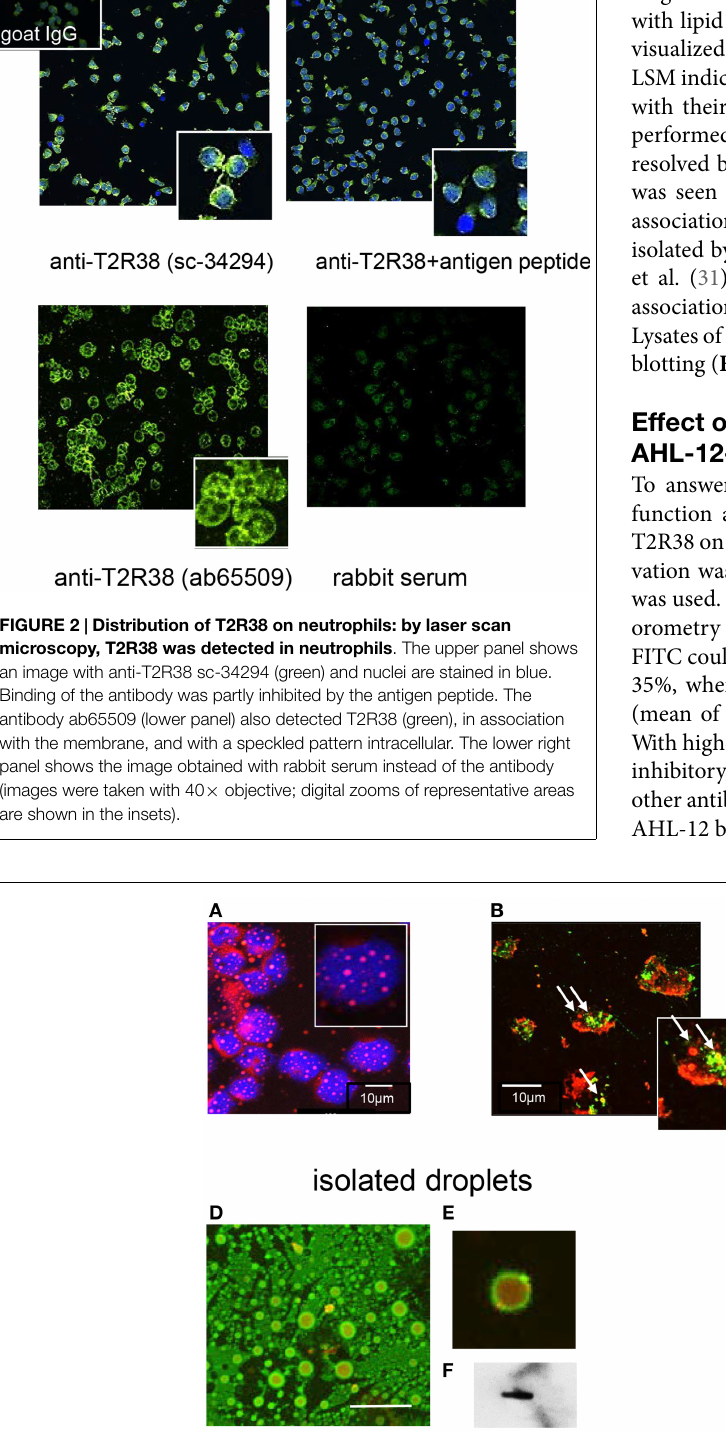
FIGURE 3 | Association of T2R38 with lipid droplets: (A) shows neutrophils stained with Nile red to visualize the lipid droplets; nuclei are in blue . (B) With anti-T2R38 (green) and staining with Nile red, droplets containing T2R38 can be recognized within the cell (marked by arrows). (C) A SIM image of the area in the rectangle shows two lipids droplets with a